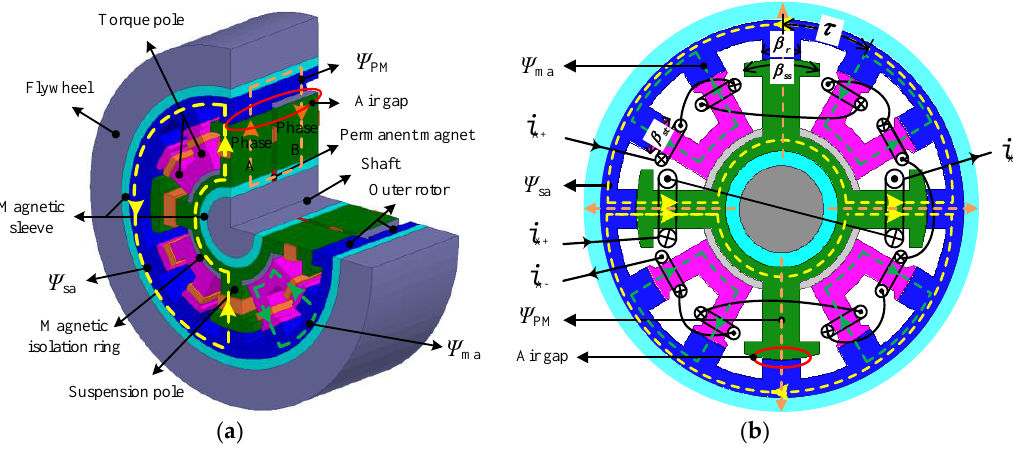
Figure 1. Machine topology diagram: ( a ) structure and composition; ( b ) winding connection and magnetic circuit.